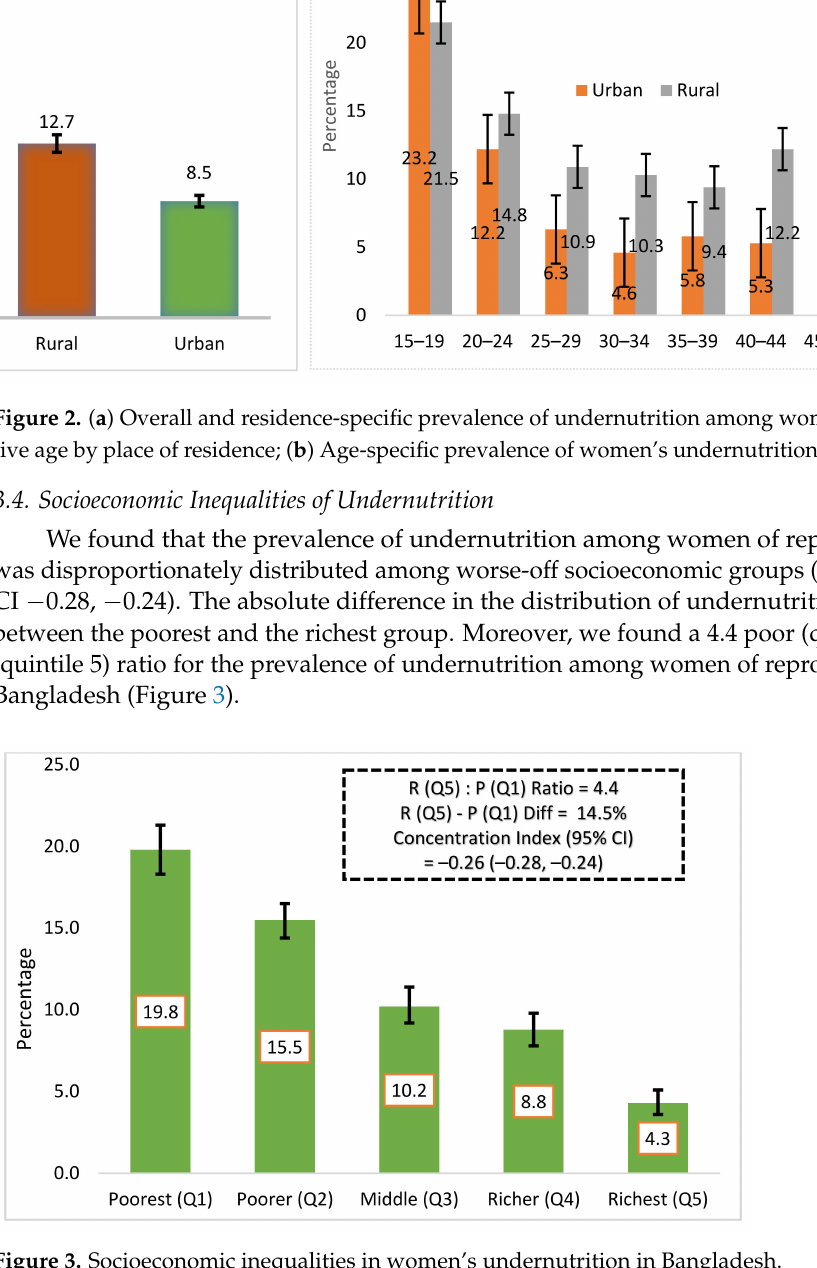
Figure 3. Socioeconomic inequalities in women’s undernutrition in